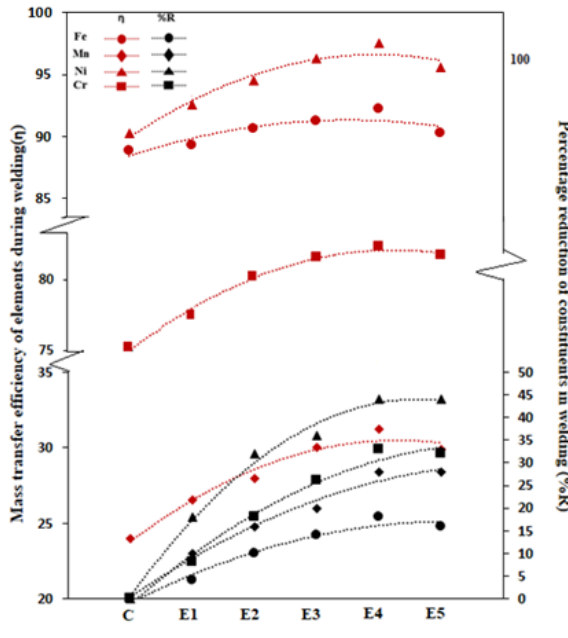
Figure 4: Mass transfer eflciency of elements during welding versus percentage reduction of constituents in welding fume